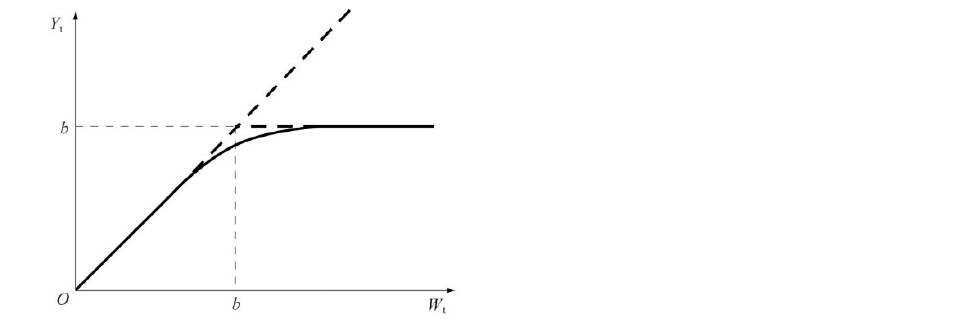
Figure 2. Curve of possible evapotranspiration and effective water quantity in the “ABCD” model. The ratio between the decrease rate of soil water content ( S ) caused by evapotranspi- ration and the potential evapotranspiration is assumed to be S t / b in the “ABCD” model.